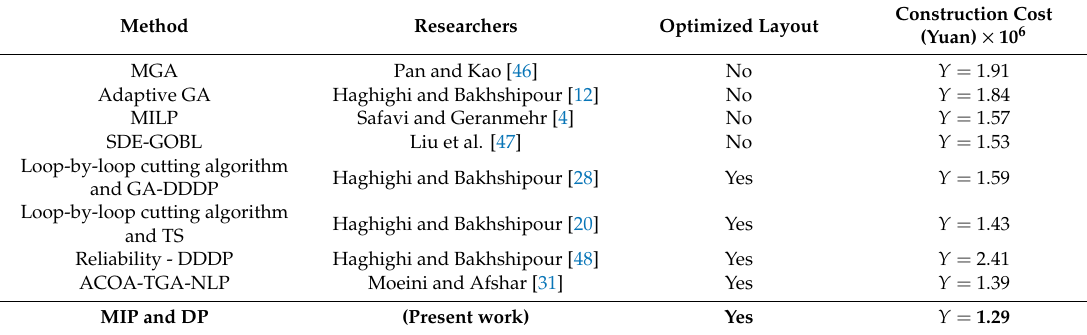
Table 2. Comparison of the construction cost for the benchmark proposed by Li and Matthew [34].